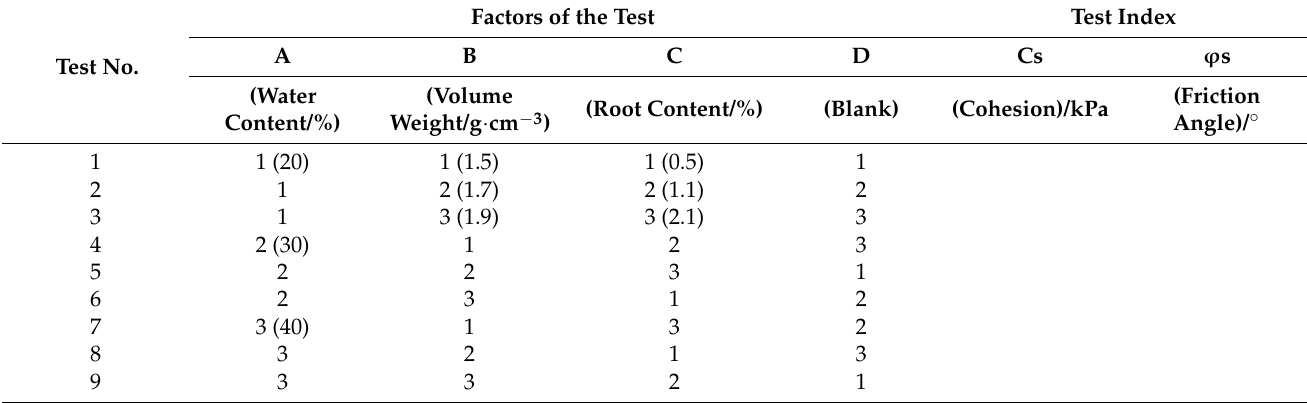
Table 3. Orthogonal test scheme for the shear strength test of the root–soil composite.